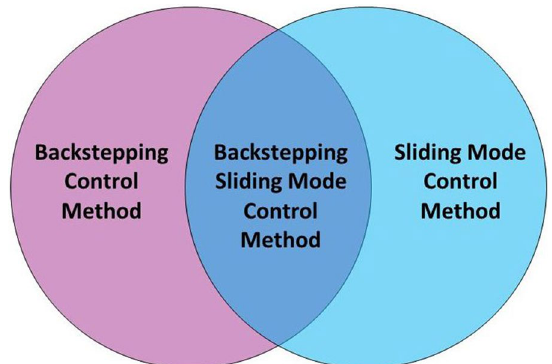
Fig. 7 Venn diagram of backstepping sliding model strategy